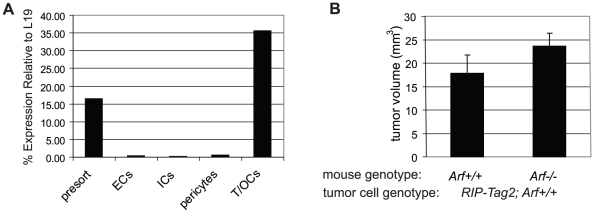

Arf expression and the effect of knockout in tumor stromal compartment.(A) Expression of Arf in the different constituent RIP-Tag2 tumor cell types. Real-time quantitative RT-PCR was performed on mRNA isolated from FACS sorted cells from RIP-Tag2 tumors [ECs (endothelial cells), ICs (immune cells), T/OCs (tumor/other cells)]. Expression levels plotted relative to L19 expression. (B) Effect of Arf knockout on tumor development of orthotopically transplanted tumor cells. 1×105 tumor cells derived from a RIP-Tag2; Arf+/+ tumor were injected into the pancreas of Arf+/+ or Arf−/− mice and allowed to grow for 4 weeks. Values represent the average tumor volume (+SEM) calculated from tumors isolated from 12 individual mice of each of the indicated genotypes. The difference between the values did not achieve statistical significance (Mann-Whitney test; p = 0.1).